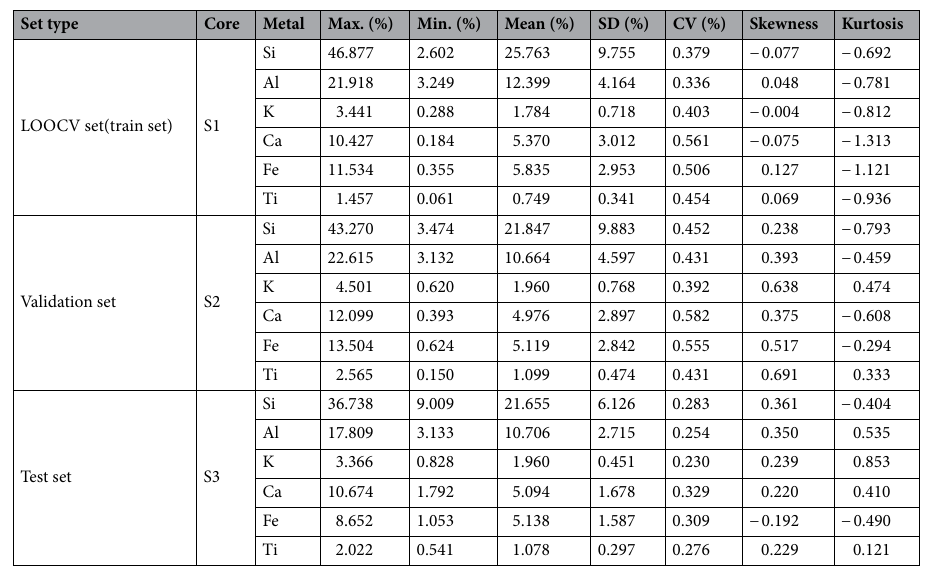
Table 2. Statistical characteristics of metal